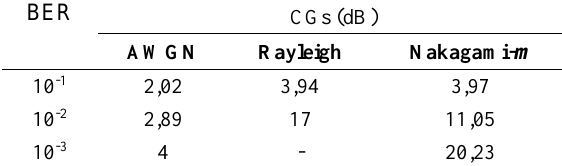
Table 3. CGs for PN sequences/LDPC